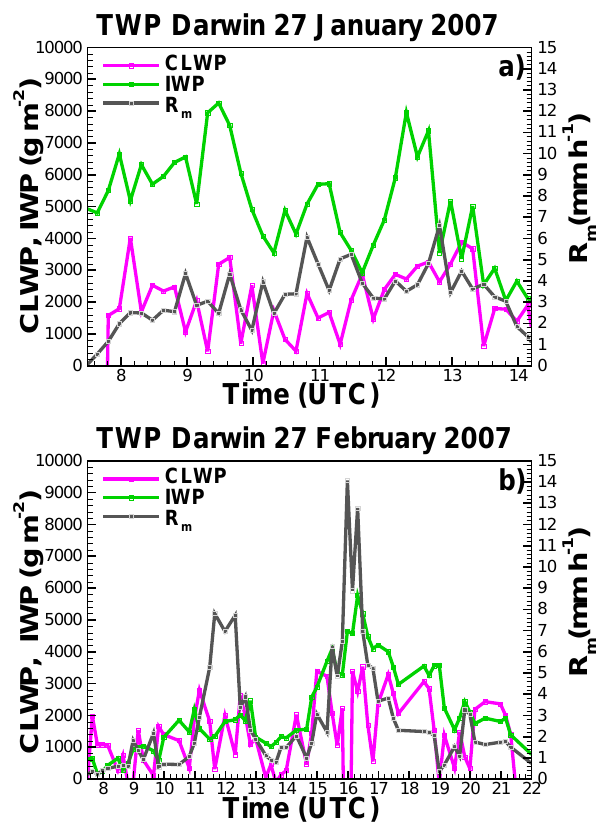
Fig. 7. Retrievals of cloud IWP, CLWP and mean layer rain rate in the vertical column above the ARM TWP Darwin site during the 27 January 2007 (a) and 27 February 2007 (b) stratiform precipitating